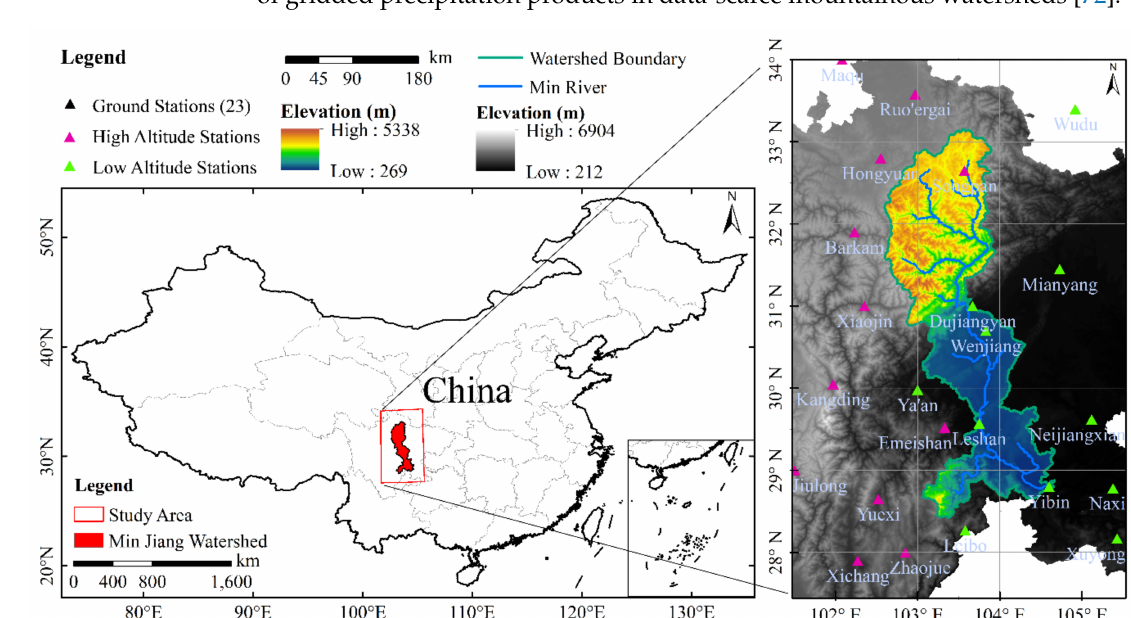
Figure 1. Spatial distribution of ground observation stations within and around the Min Jiang watershed. These rain gauges provided consistent observations during the study period (2000–2016). High altitude stations have the elevation ranging from 1500 to 3500 m, and low altitude stations have the elevation ranging from 300 to 1500